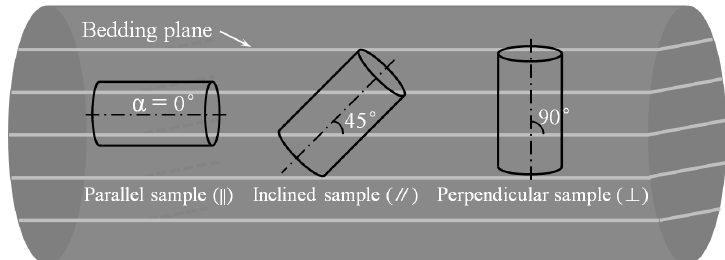
Figure 5. Schematic illustration of sample preparation from initial big core and definition of loading angle between bedding planes and sample axis ( α = 0 ◦ ,45 ◦ ,90 ◦